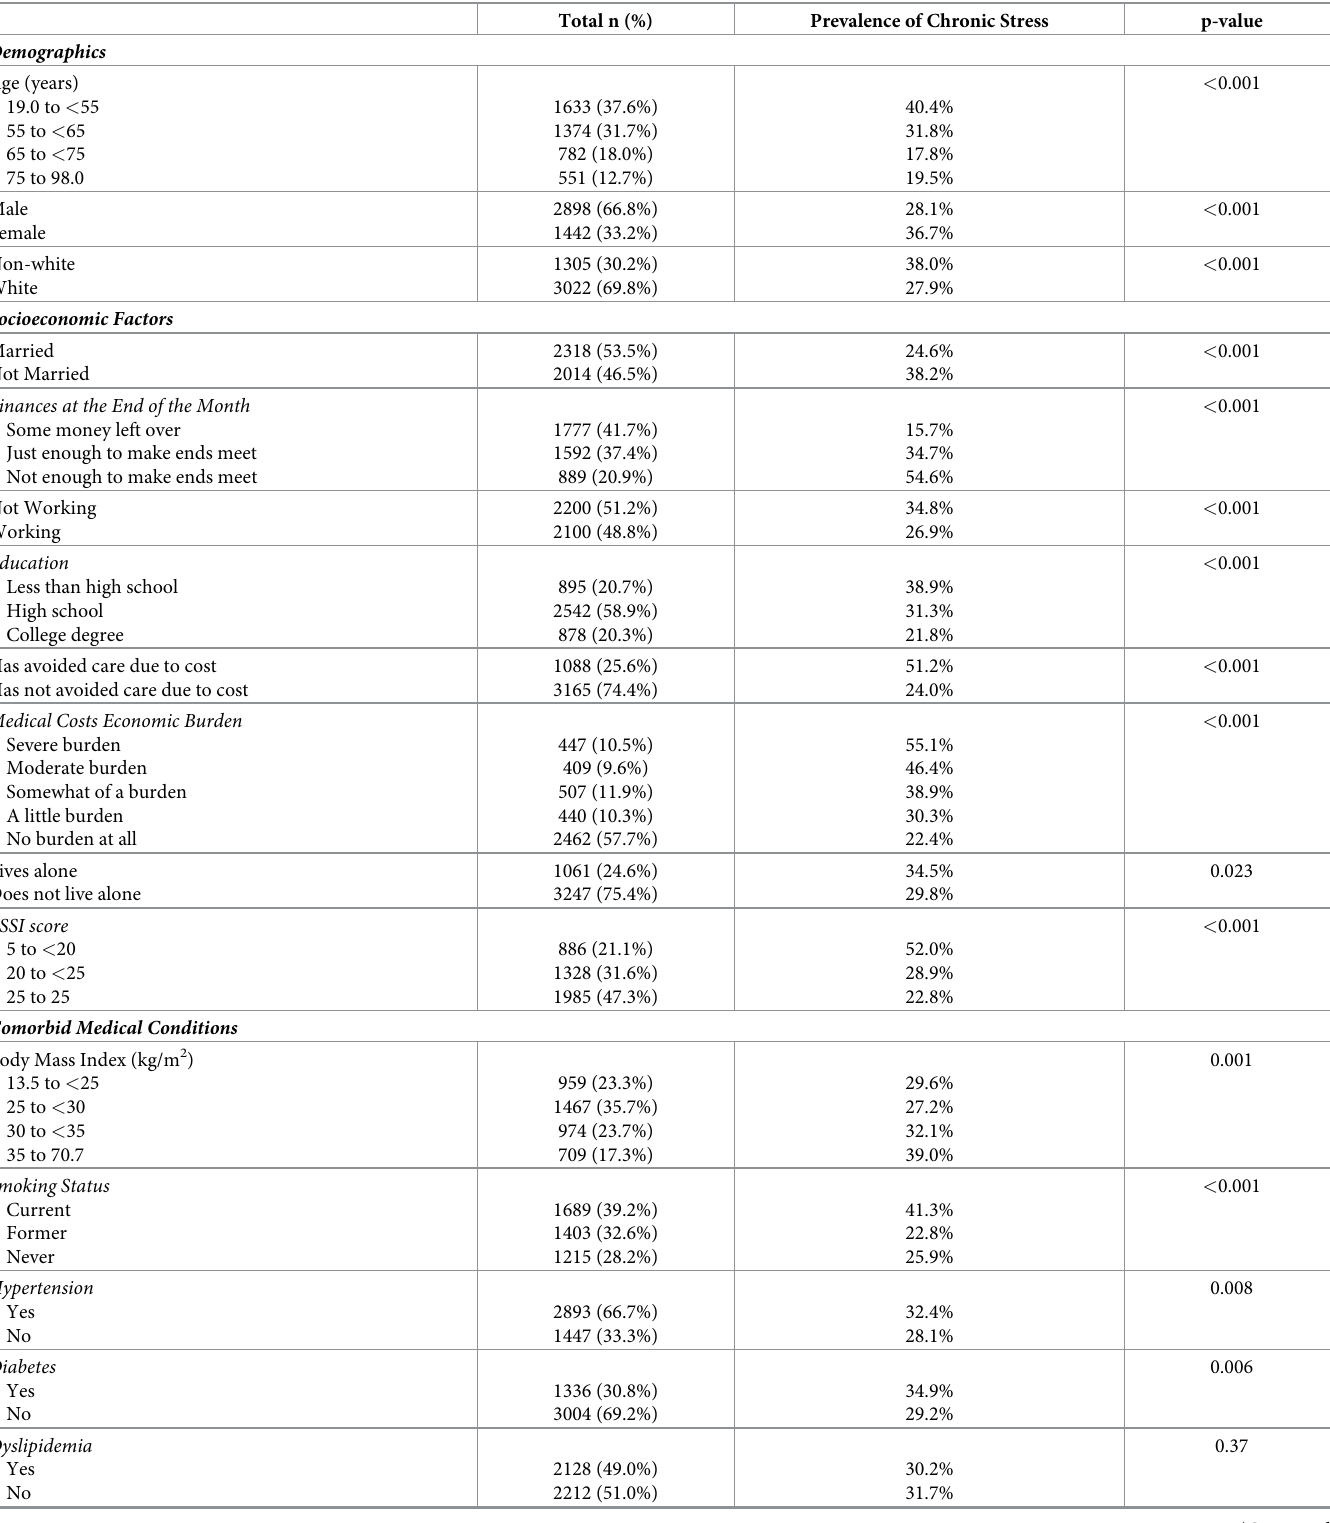
Table 1. Baseline patient characteristics and prevalence of chronic stress in patients from the TRIUMPH